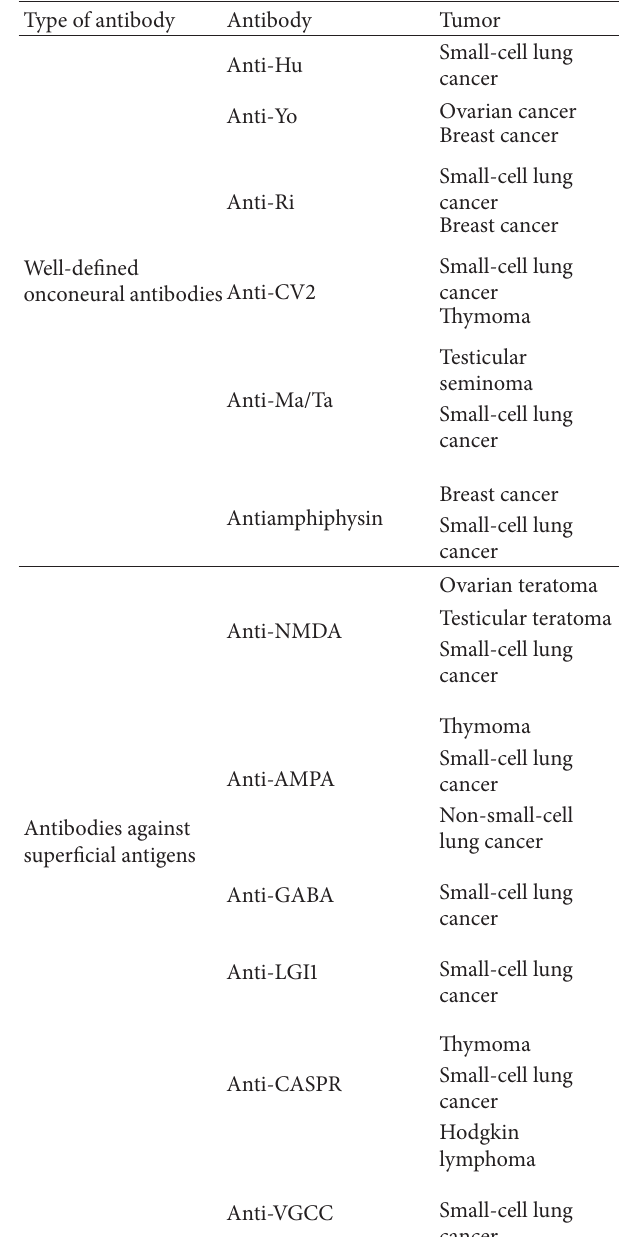
Table 2: The most common onconeural antibodies and superficial antigen antibodies [1, 17,